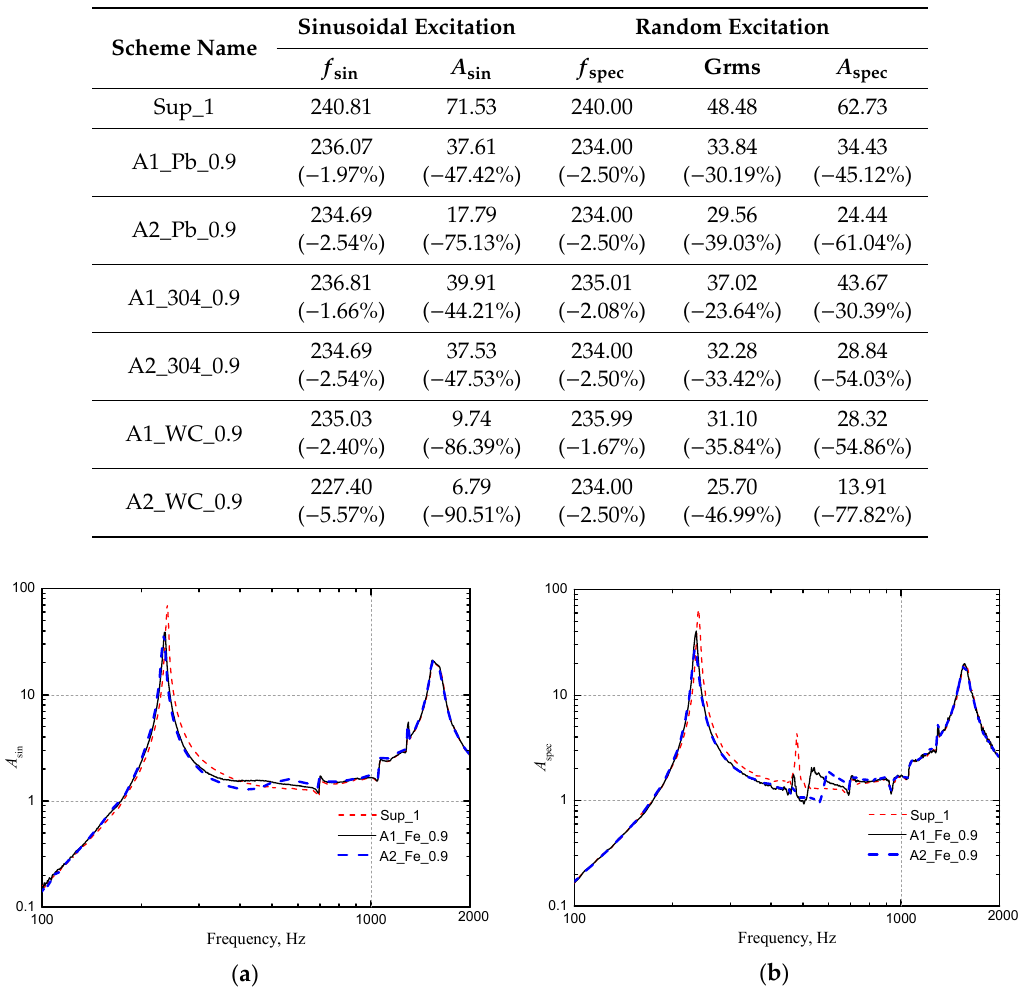
Figure 12. Experiment results of 2 mm stainless steel particles for A1 and A2 cavity (layering in Y-direction of the cavity): ( a ) Sinusoidal excitation; ( b ) Random excitation.